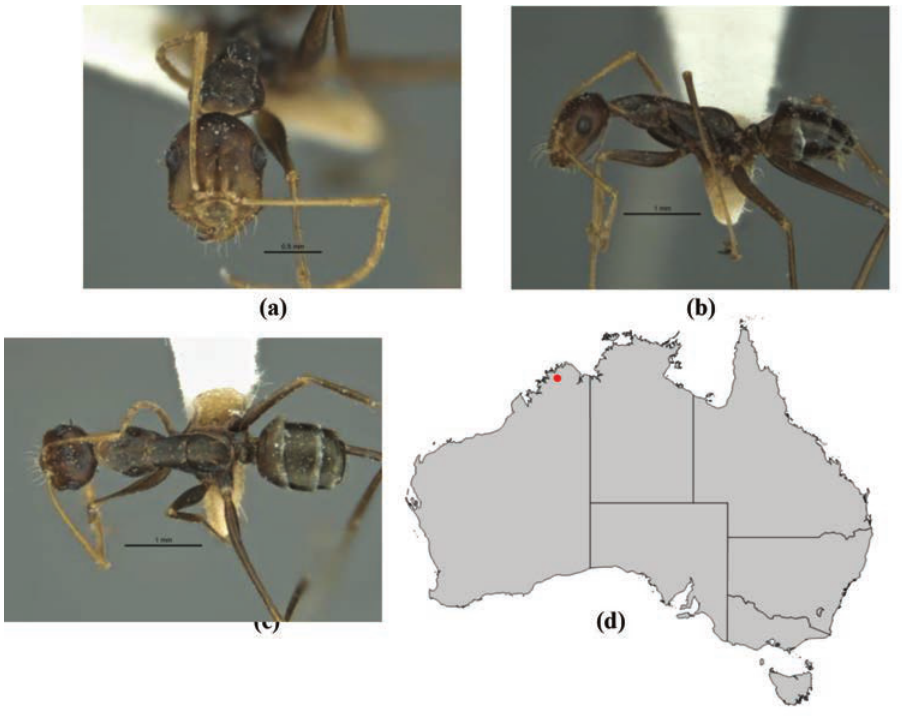
Figure 21. Melophorus tenuis sp. n.: minor worker holotype (ANIC32-900210) frons ( a ), profile ( b ) and dorsum ( c ); distribution map for the species ( d ). Low resolution scale bars: 1 mm ( b, c ); 0.5 mm ( a ). proximately vertical or weakly oblique. Mesosoma . Integument of pronotum, mes- onotum and mesopleuron moderately shining and shagreenate throughout; anterior mesosoma in profile flattened, promesonotum on same plane as propodeum; erect pronotal setae absent; in profile, metanotal groove shallow, indicated mainly by an angle; propodeum shining and shagreenate; propodeum elongate, smoothly rounded; propodeal dorsum and declivity confluent; erect propodeal setae always absent; ap- pressed propodeal setulae short, separated by more than own length and completely inconspicuous; propodeal spiracle situated at least twice its width from the declivitous face of propodeum, and shorter (length < 0.50 × height of propodeum). Petiole . In profile, petiolar node subcuboidal, its vertex bluntly rounded; in full-face view, shape of petiolar node uniformly rounded; node shining and faintly shagreenate. Gaster . Gaster shining, shagreenate (‘LP record’ appearance); pilosity of first gastral tergite consisting of well-spaced short, inconspicuous, appressed setae only, erect setae always absent. General characters . Colour uniformly dark olive-brown. Measurements. Worker (n = 1): CI 82; EI 30; EL 0.25; HL 0.99; HW 0.82; ML 1.72; MTL 1.18; PpH 0.16; PpL 0.67; SI 168 Comments. Melophorus tenuis has an appearance somewhat reminiscent of Melo- phorus attenuipes and Melophorus mullewaensis , but, although it is likely closely